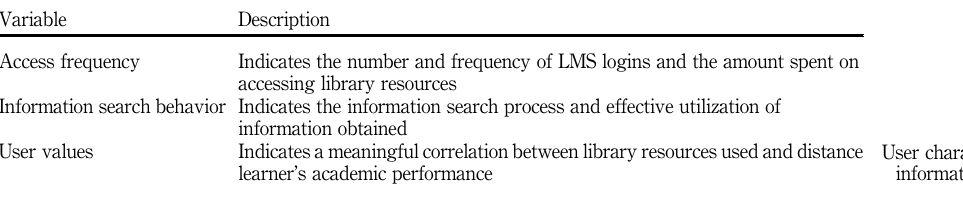
Table II. User characteristics